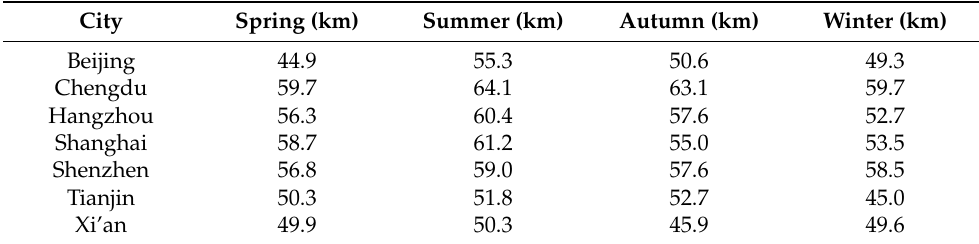
Table 4. Average daily vehicle kilometers travelled in different seasons.